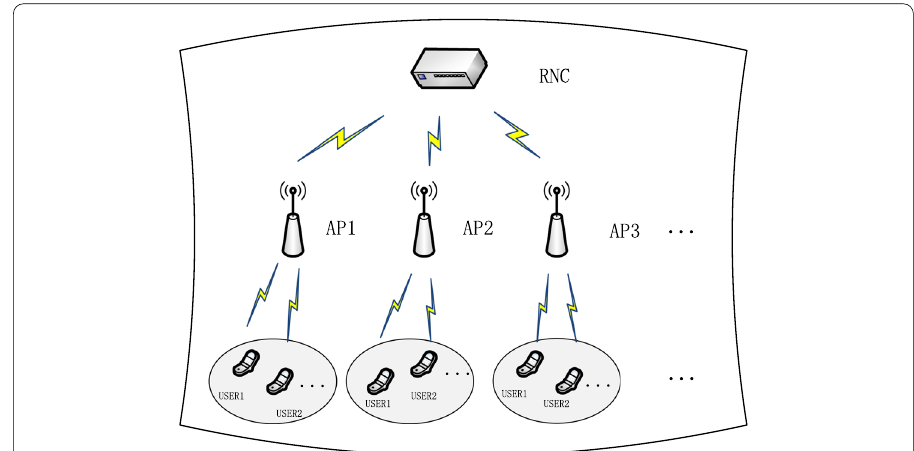
Fig. 1 System model based on game theory. A three-layer heterogeneous fusion network model is composed of RNC, base stations and base station